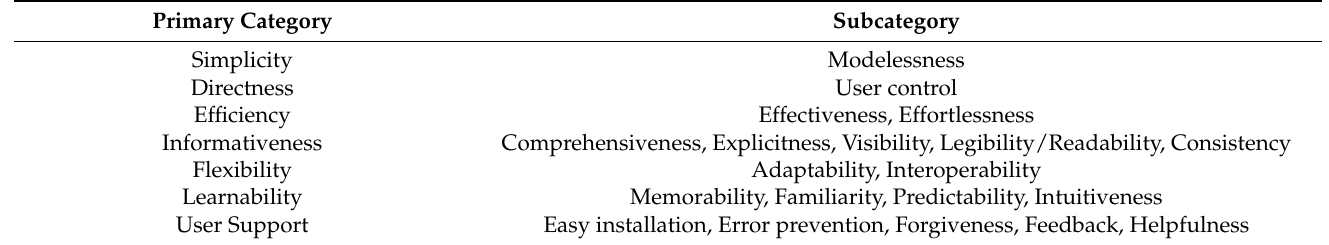
Table 1. Classification of usability.